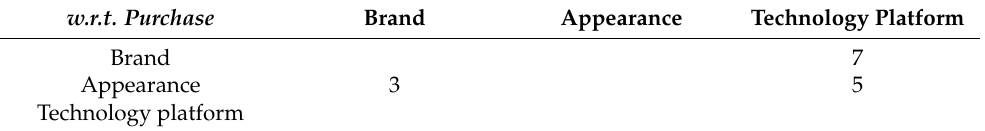
Table 9. Pairwisecomparisonmatrixofsub-criteriaofCARIDENTITYwithrespecttoPURCHASEdecision.